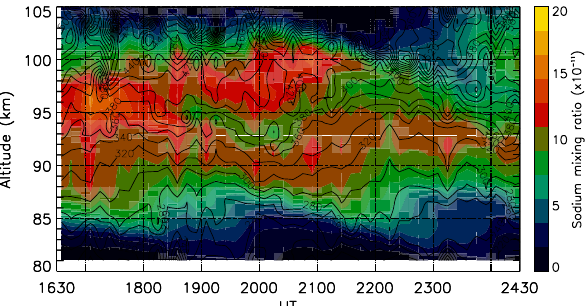
Figure 8. Variations of MF radar echo intensity from 80 to 105km (in virtual height) between 16:30 and 24:30UT on 29 October 2010. The black lines are contours of the neutral temperature (K) shown in Fig. 1a. contour lines of the neutral temperature shown in Fig. 1a.